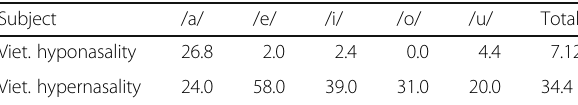
Table 4 Degrees of the slopes represented in Vietnamese hyponasality and